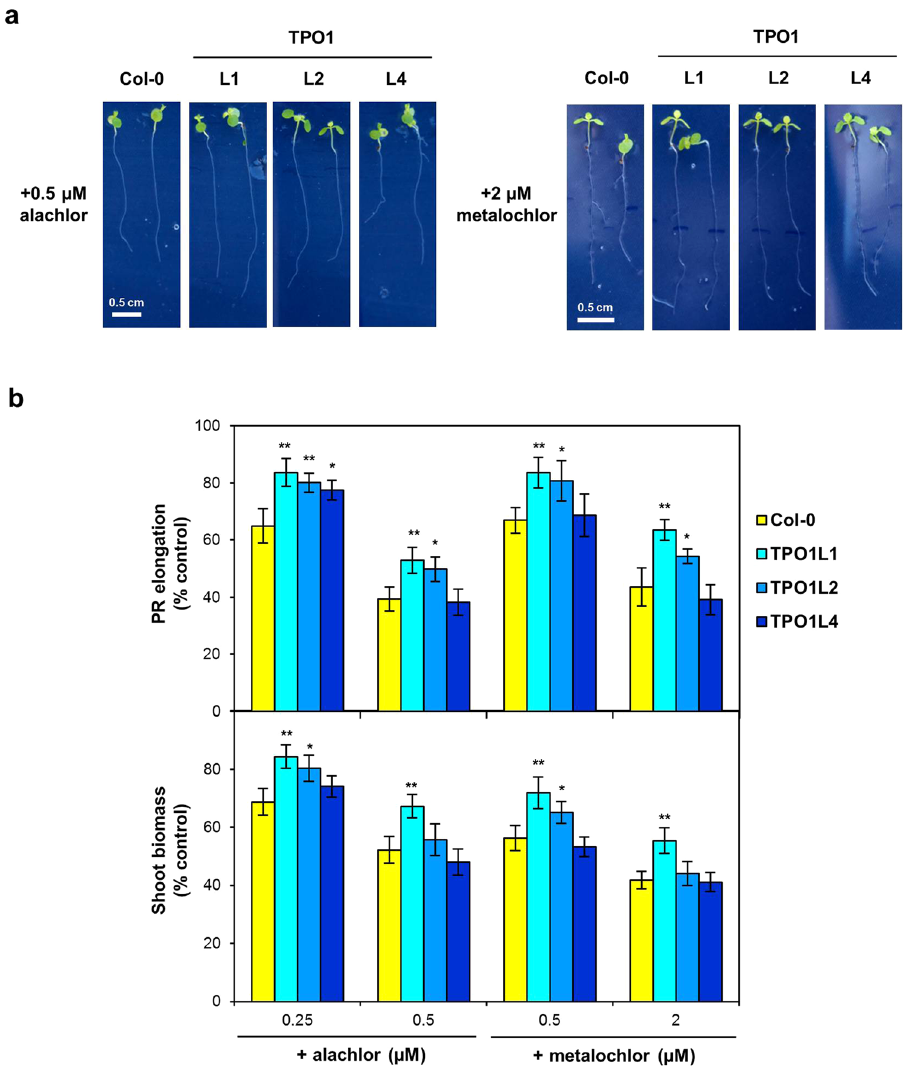
Figure 6. Effects of an alachlor or metalochlor challenge on transgenic Arabidopsis lines expressing the yeast Tpo1p transporter. ( a ) Representative images of 7-d old seedlings of the wild type (Col-0) and TPO1 (TPO1L1, L2, L4) transgenic lines grown on media containing alachlor (left panel) or metalochlor (right panel). Plant growth under control conditions is shown in Fig. 1 and Table 1. ( b ) Effect of alachlor or metalochlor toxicity on PR elongation (upper panel) and shoot biomass (lower panel) of seedlings of the wild type (Col-0) and TPO1 (TPO1L1, L2, L4) transgenic lines. Values represent means ± SD ( n = 8), with similar results being obtained in three independent experiments performed with different seed batches. Asterisks denote statistically significant differences between ScTPO1 -expressing lines and the wild type ( * P < 0.05, ** P < 0.01; Student’s t